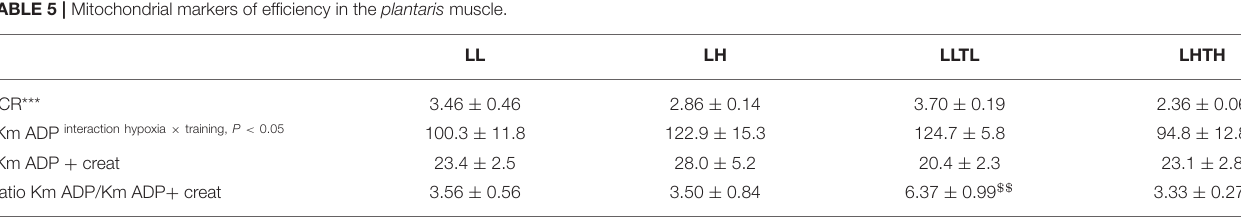
TABLE 5 | Mitochondrial markers of efficiency in the plantaris